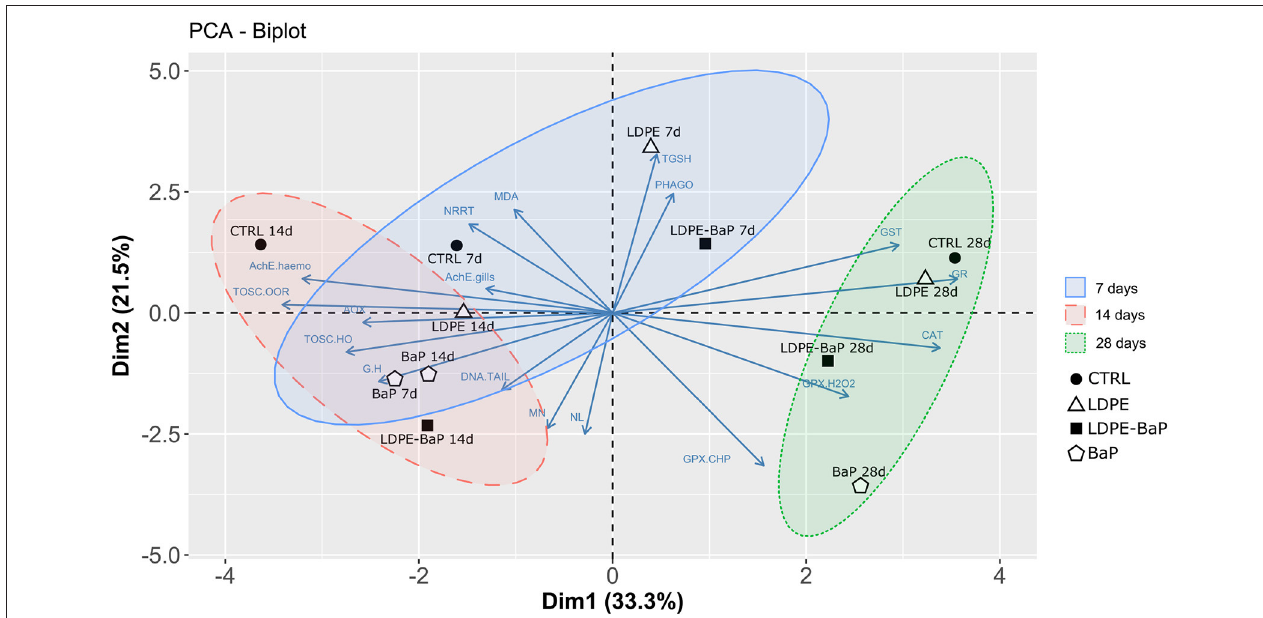
FIGURE 7 | Multivariate PCA analysis on biomarker data in mussels exposed to various microplastics treatments: CTRL, control; LDPE, virgin low density polyethylene; BaP, benzo(a)pyrene alone; LDPE-BaP, benzo(a)pyrene-contaminated polyethylene.